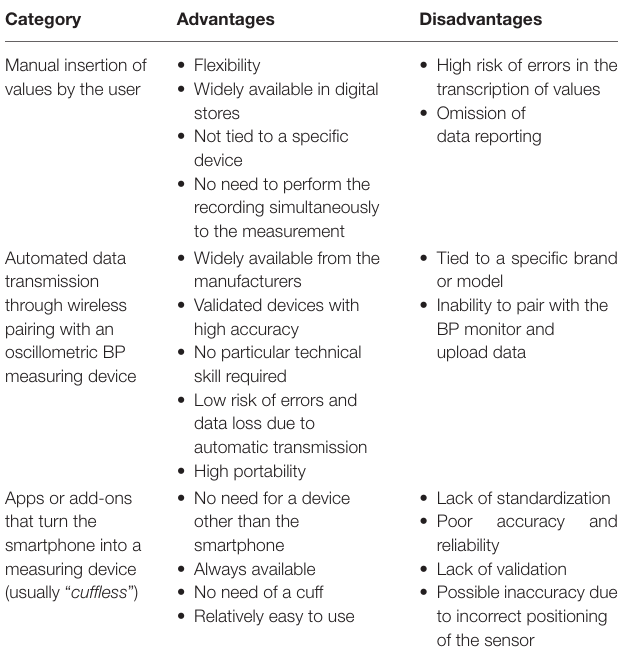
TABLE 5 | Main categories of m-health apps for BP measurement management. Category Advantages